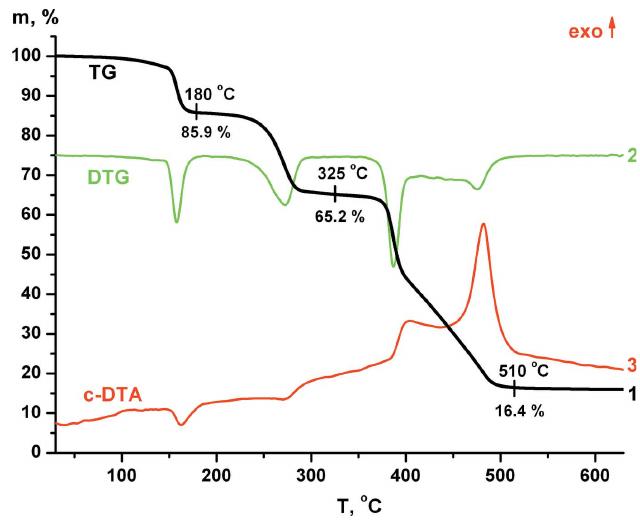
Figure 2 Curves of thermal analysis for [Zn(btrh)(bdc)] (cid:2) DMF in O 2 /Ar (21%) atmosphere; 1 TG, 2 DTG, 3 c-DTA.